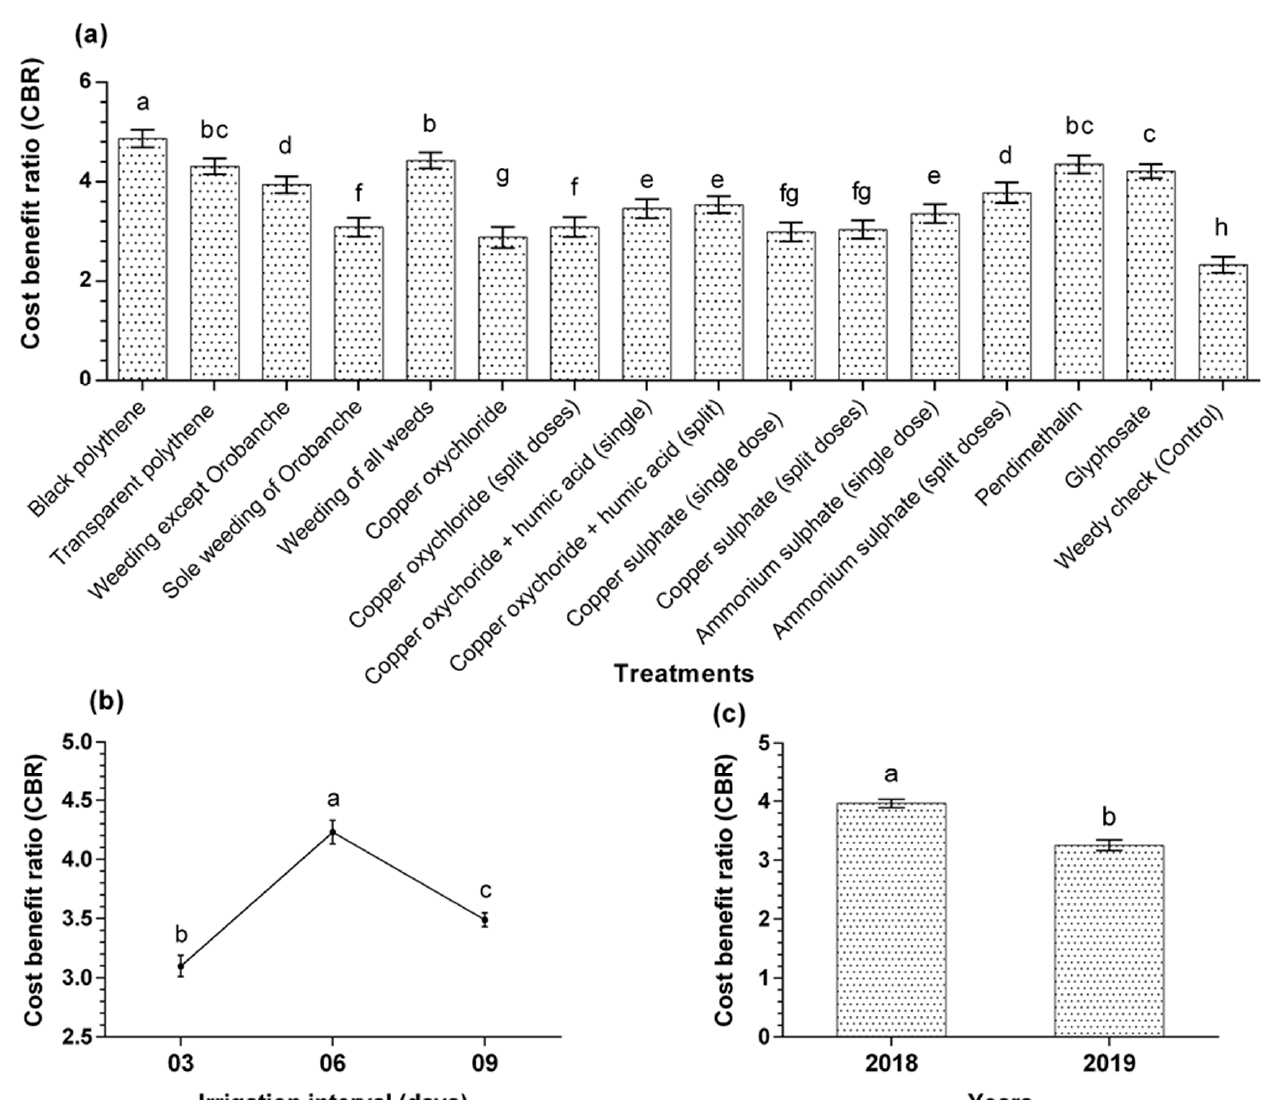
Figure 15. Effect of irrigation intervals and weed management treatments on cost/benefit ratio (CBR). Based on the Least significant difference test, line and column ± standard error followed by different alphabetical letters are significantly different from each other at a 5% level of probability . ( a ) Effect of treatments on CBR. ( b ) Effect of irrigation intervals on CBR. ( c ) Effect of different years on